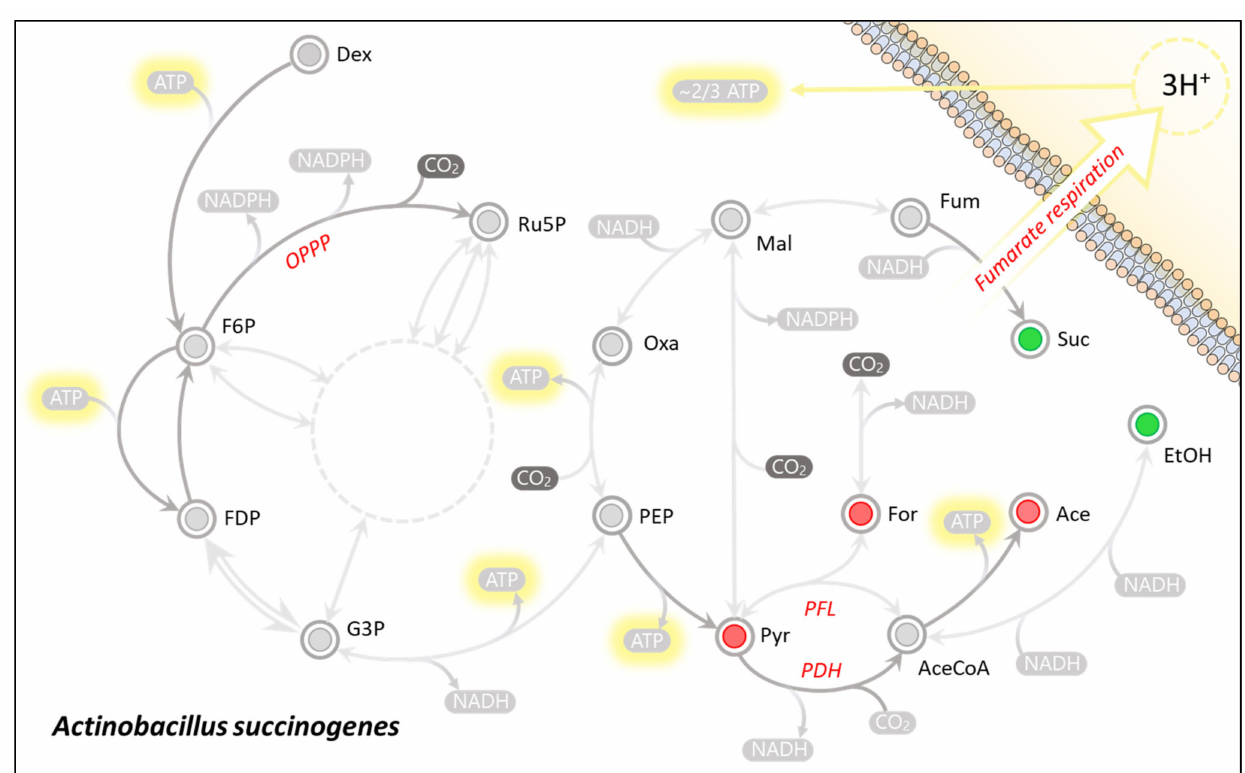
Figure 3. Main nodes of Actinobacillus succinogenes central carbon metabolism. Unidirectional arrows (dark) indicate proposed unidirectional fluxes [3], where all other fluxes are considered to be reversible. The dotted circle represents the pentose phosphate pathway overall reaction of the transketolase carbon exchange mechanism simplified to 3Ru5P (cid:10) 2F6P + G3P. The Red nodes (incl. For, Ace, and Pyr) highlight metabolites which are net NADH producing metabolites, whereas green nodes (inc. Suc and EtOH) highlight net NADH consuming